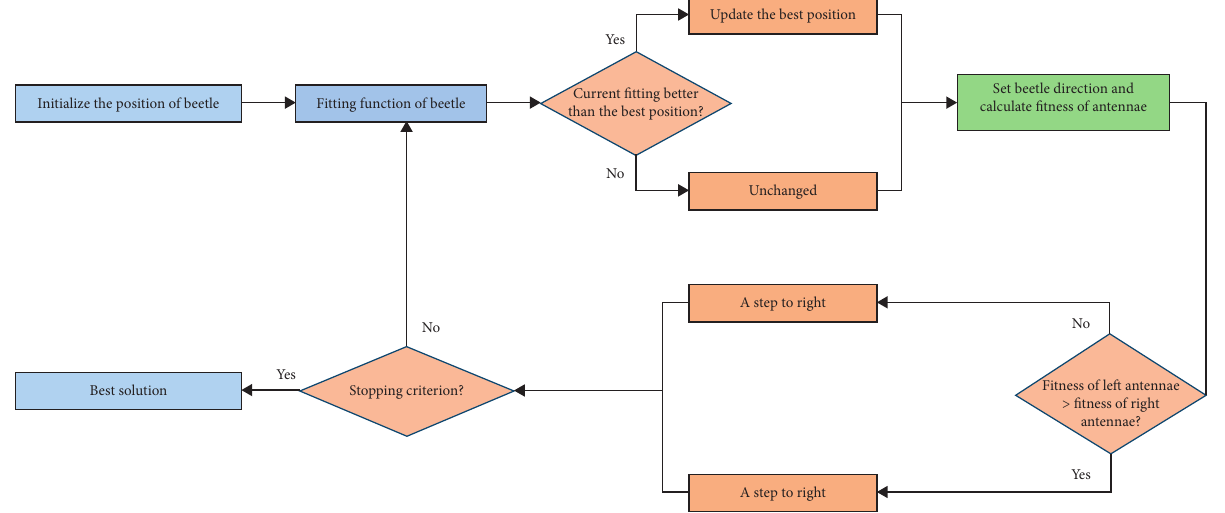
Figure 3: Work chart of the BAS algorithm. Table 1: Physical properties of the cement. Table 2: Physical properties of coarse